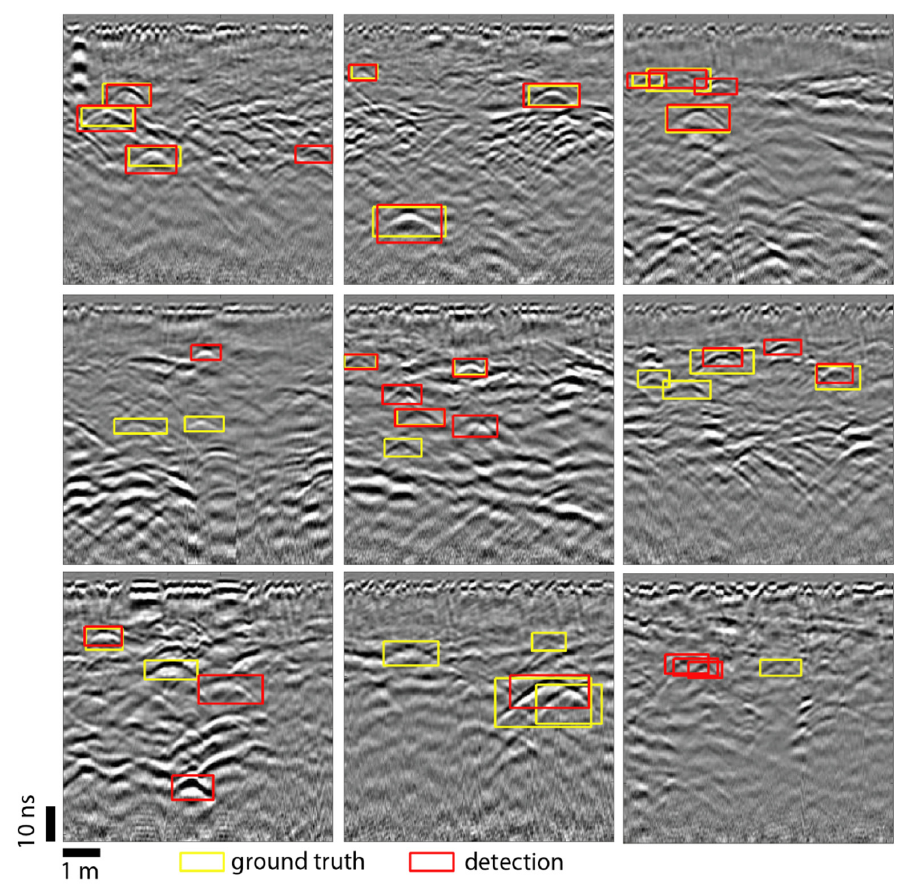
Figure 5. Examples for the detection results on the test dataset. If red (detected) and yellow (ground truth) boxes overlap with an IoU > 0.5, they count as true positive (TP). If there is only a ground truth box, it is a false negative (FN). If hyperbolae are detected by the network but without ground truth, they are false positive (FP).